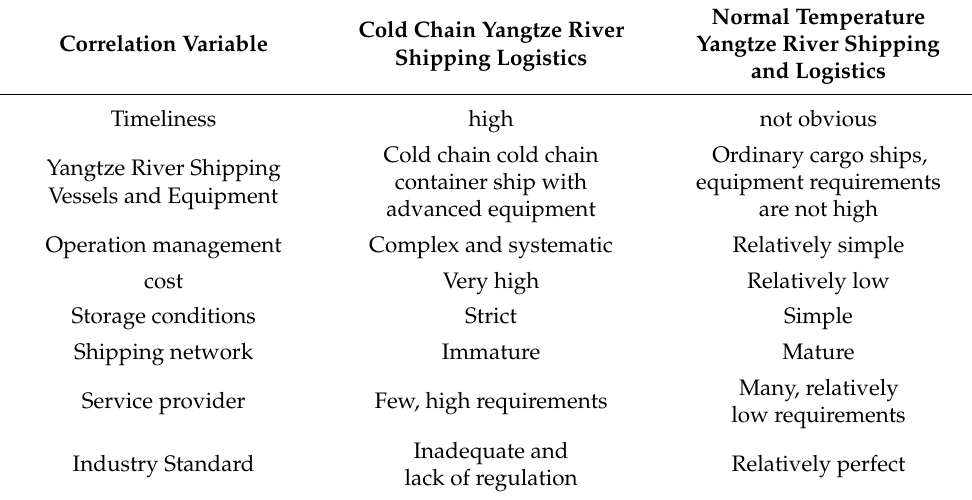
Table 4. A comparison of the difference between the cold chain Yangtze River shipping logistics and the normal temperature Yangtze River shipping logistics.